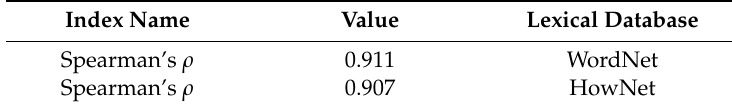
Table 4. The correlation ρ between computed relatedness and expert ratings.